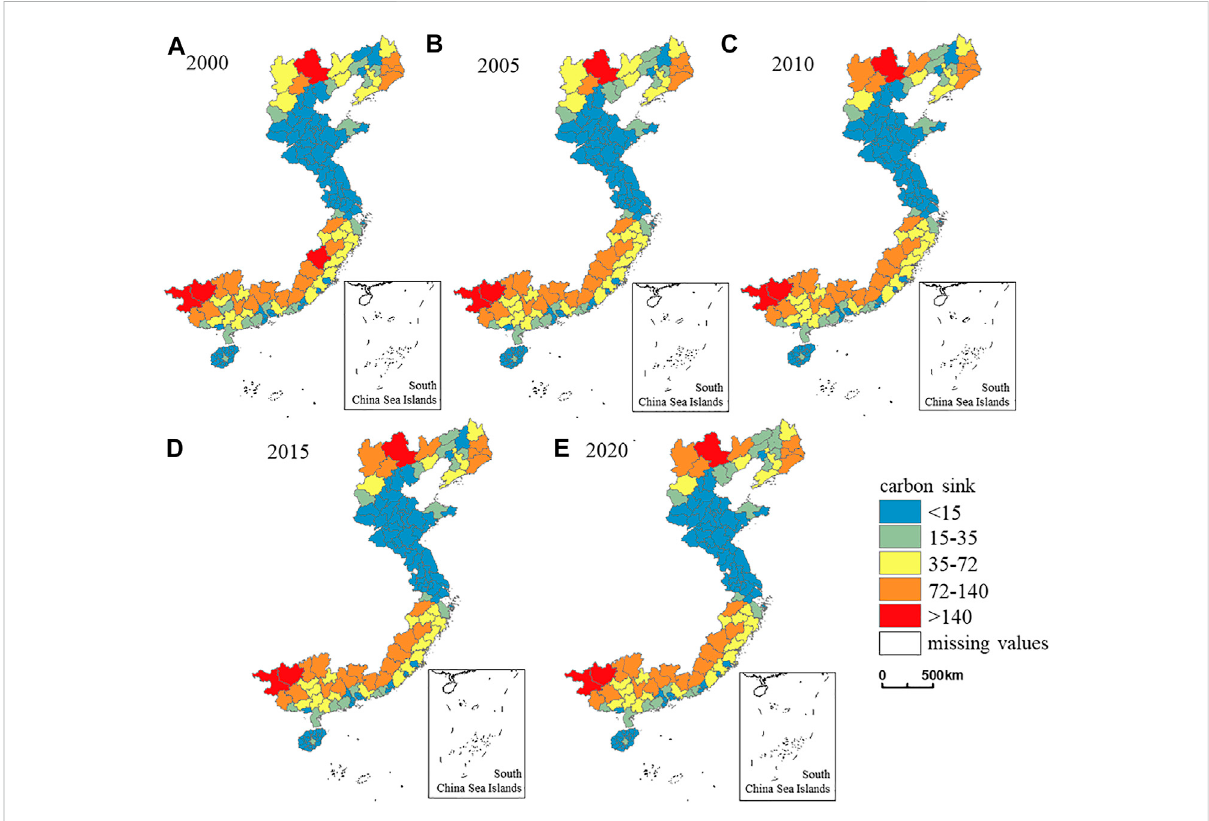
FIGURE 5 Spatial and temporal distribution of carbon sinks from 2000 to 2020 (million